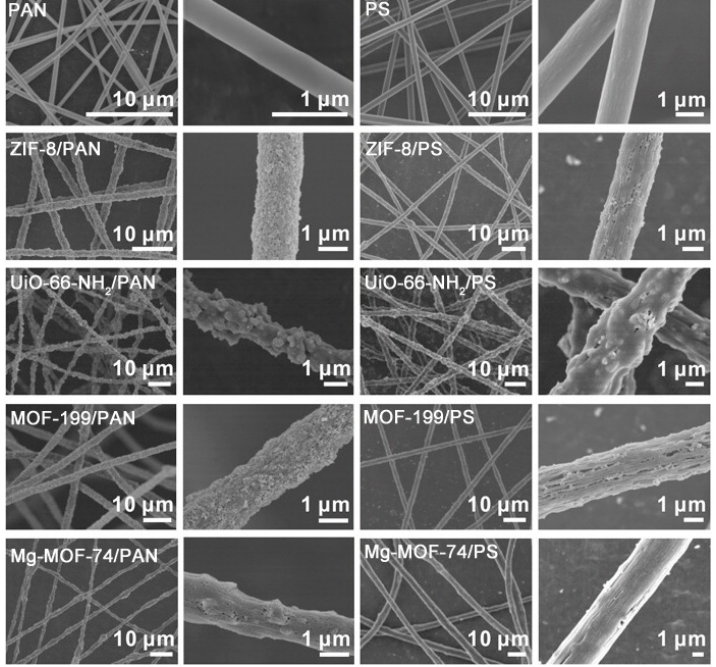
Figure 10. SEM images of polymer and various MOFs loaded nonwoven fabrics. Reproduced and adapted from Ref. [58]; Copyright (2016), ACS Journal of American Society.